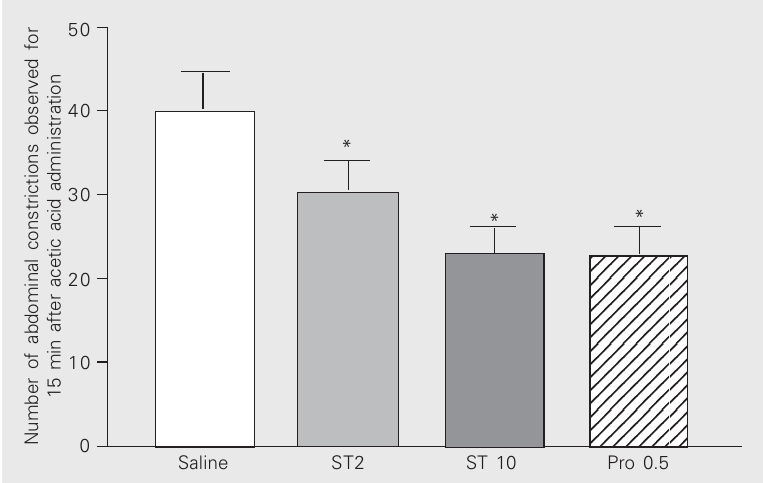
Figure 2. Effect of Sapindus trifoliatus extract at 2 (ST 2) and 10 mg/kg (ST 10), ip , on 0.3% acetic acid-induced abdominal constrictions. Each column indicates the mean ± SEM of the number of constrictions exhibited by 10 mice for 15 min after acetic acid injection. Pro 0.5 = 0.5 mg/kg prochlorperazine. *P < 0.001 compared with saline-treated animals (ANOVA followed by Dunnetts’ test).